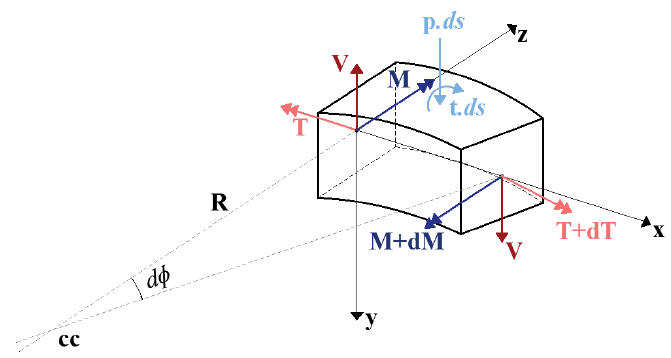
Figure 1. Internal forces in a curved beam element. Adapted from Barbosa